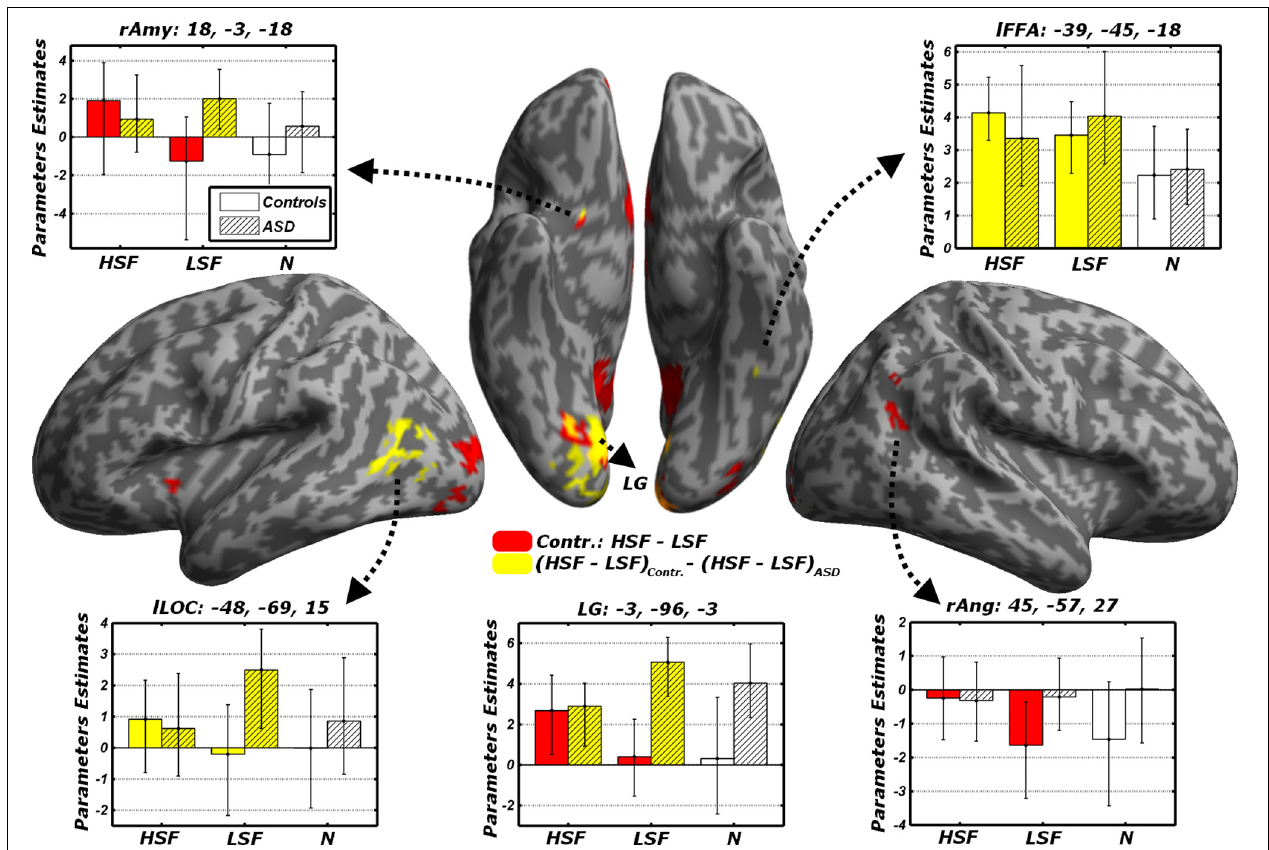
FIGURE 6 | Discrimination task: dissociated responses to LSF or HSF emotional information. Whole-brain maps showing significant increase of neural activity to HSF but not LSF emotional cues in the contrast HSF − LSF for Controls (red blobs). Furthermore, regions significantly associated with the interaction contrast ( HSF − LSF ) Controls − ( HSF − LSF ) ASD , which tests group-specific differential responses to HSF and LSF emotional cues are also displayed (yellow blobs). Data are overlaid on an inflated brain surface.